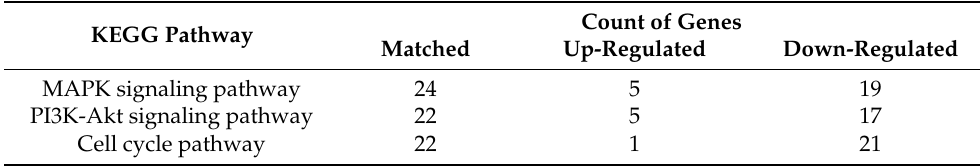
Table 2. Results of pathway mapping for 2-fold changed DEGs by